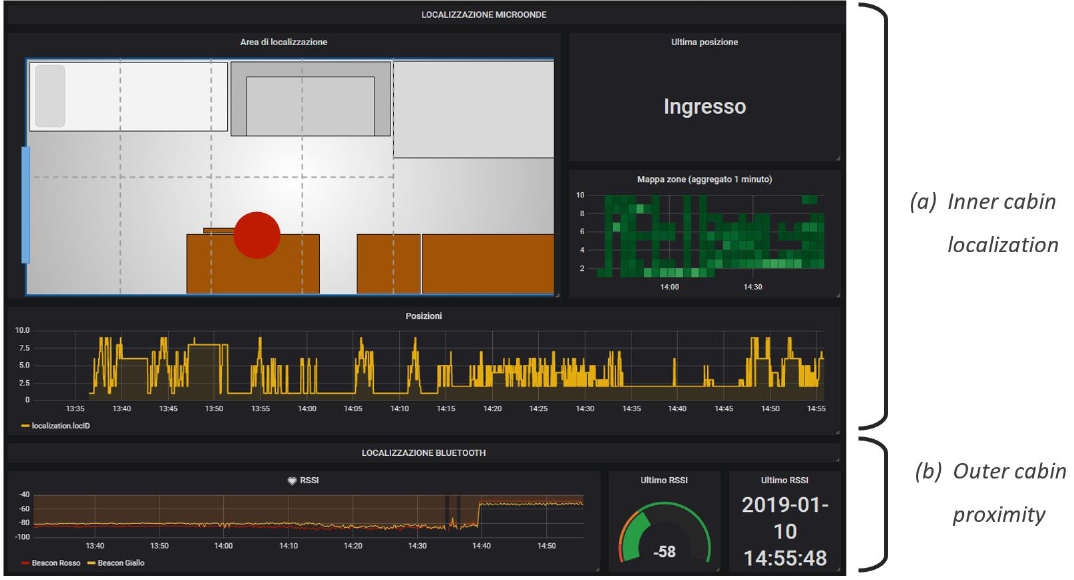
Figure 7. Inner cabin and outside proximity localization panels.